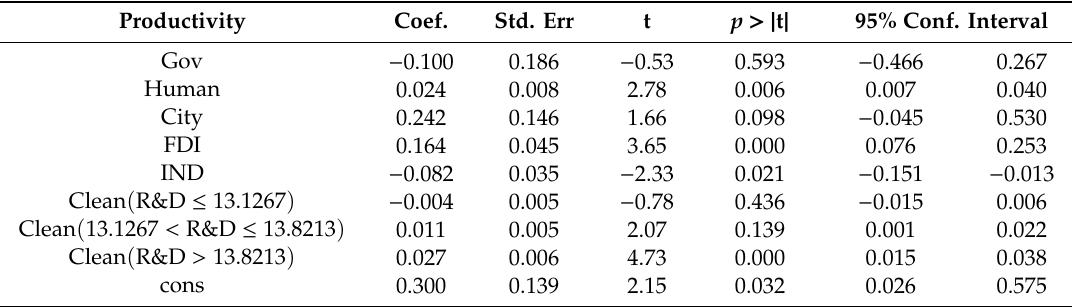
Table 6. Results of the robustness